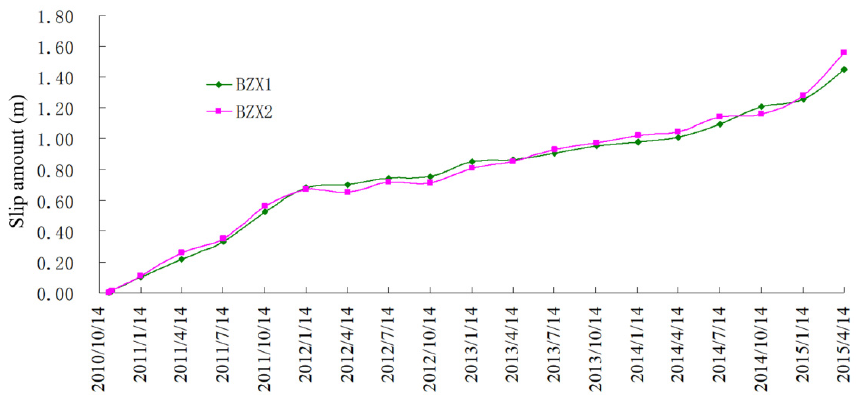
Figure 11. Slip–time monitoring curve of fault F2 observed by the mark line.